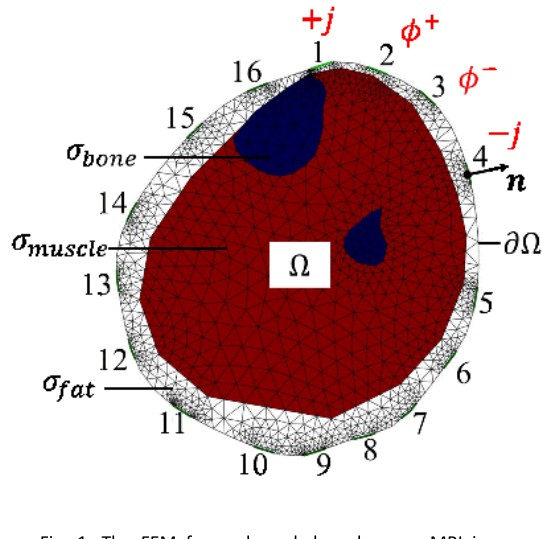
Fig. 1. The FEM forward mesh based on an MRI image. White, red, and blue part indicate SAT layer, muscle, and bone,